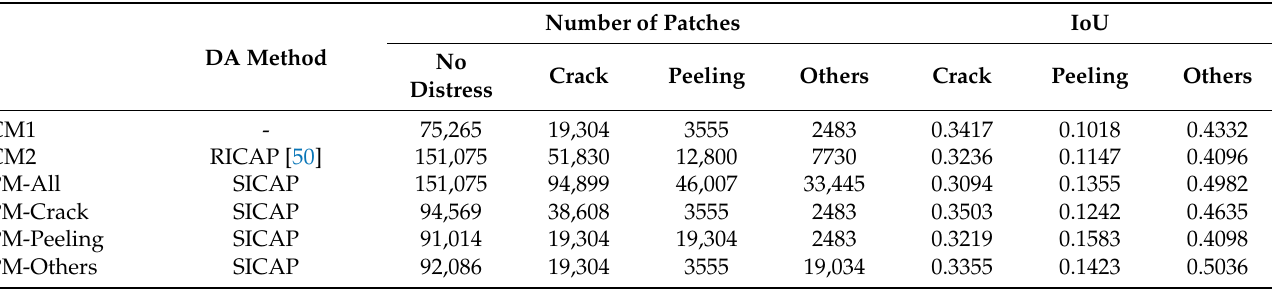
Figure 6. Examples of the results of the proposed method in line B. Figures ( A – D ) show the tunnel walls at various locations on line B. Table 3. Number of patches used for training after data augmentation and the average of IoU when detecting “crack”, “peeling”, and “others” based on each data augmentation method (DA method) in the ablation